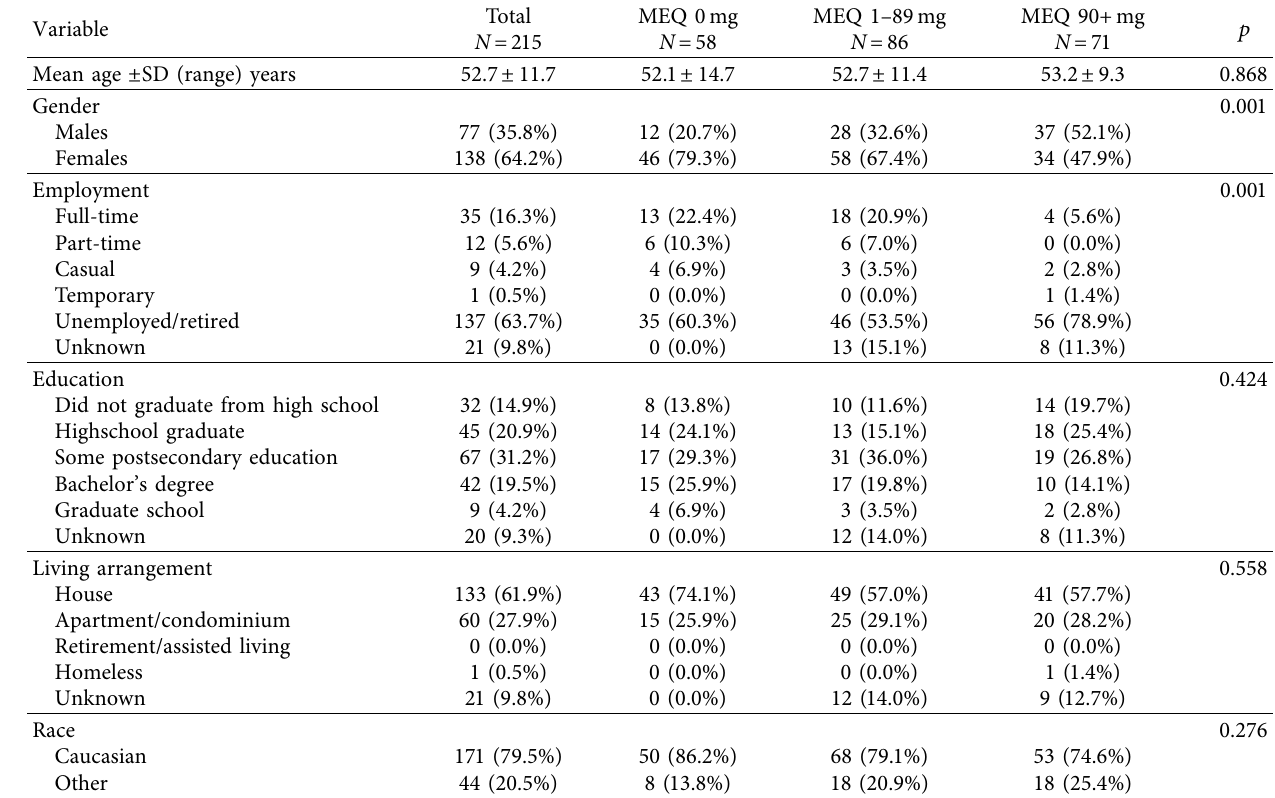
Table 1: Sociodemographic information and descriptive statistics for the total sample and three morphine equivalent